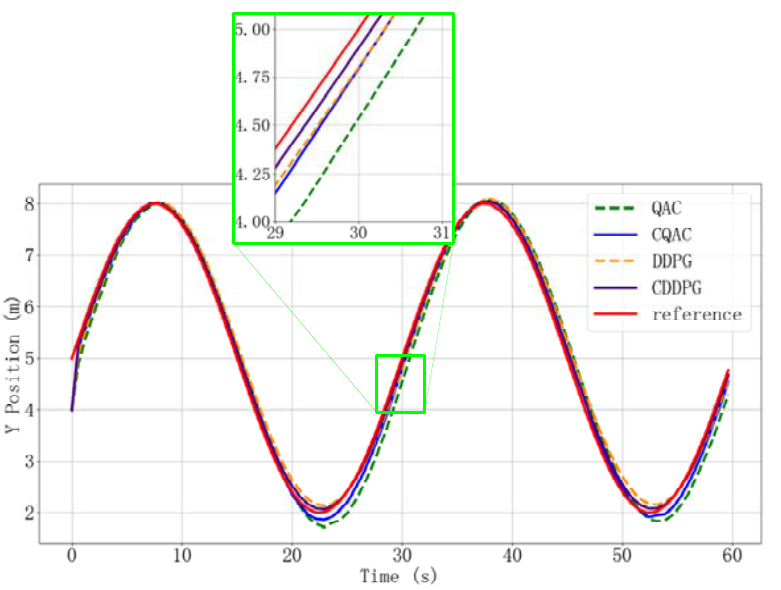
Figure 11. Tracking track of X position.